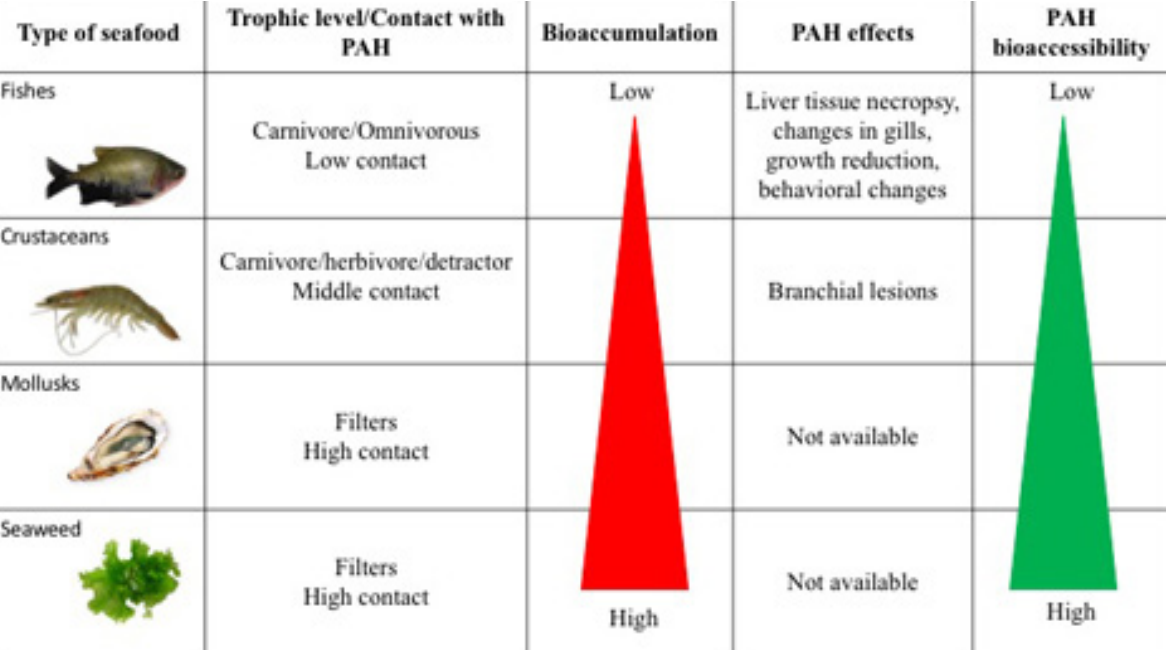
Figure 1. Oil spill impacts in different types of aquatic organisms based on where they live, feed, and breed and how mobile they